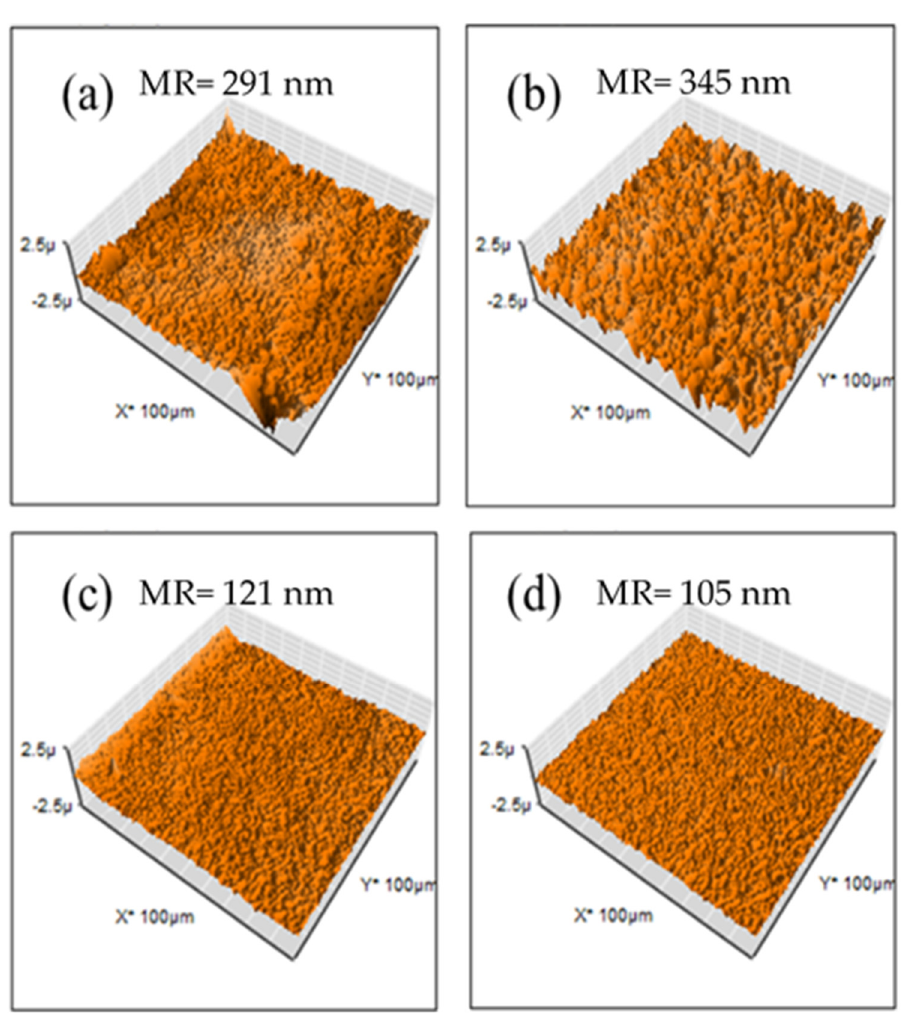
Figure 9. AFM images for Fumion ® -based membranes: ( a ) F1, ( b ) F2, ( c ) F3 y ( d ) F4.